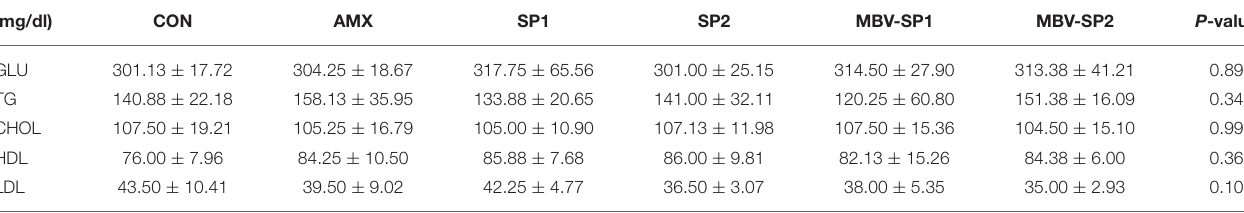
Data were presented as mean ± S.D. GLU, glucose; TG, triglyceride; CHOL, cholesterol; HDL, high-density lipoprotein; LDL, low-density lipoprotein. Control (basal diet); AMX, basal diet plus 0.1% amoxicillin; SP1, basal diet plus 0.05% microalgae; SP2, basal diet plus 0.1% microalgae; MBV-SP1, basal diet plus 0.05% MBV-enriched microalgae; MBV-SP2, basal